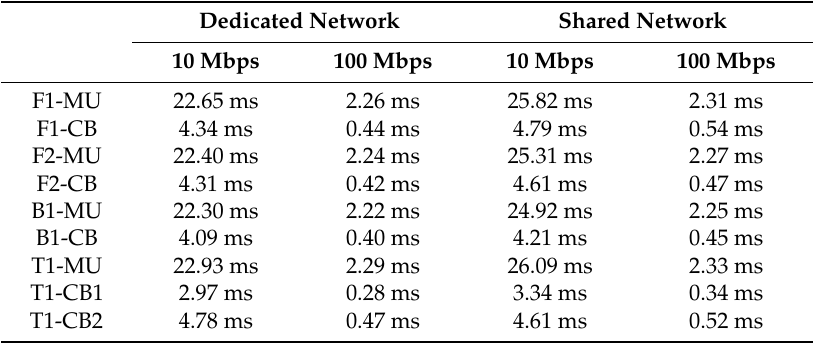
Table 10. End-to-end delay for di ff erent protection IEDs.